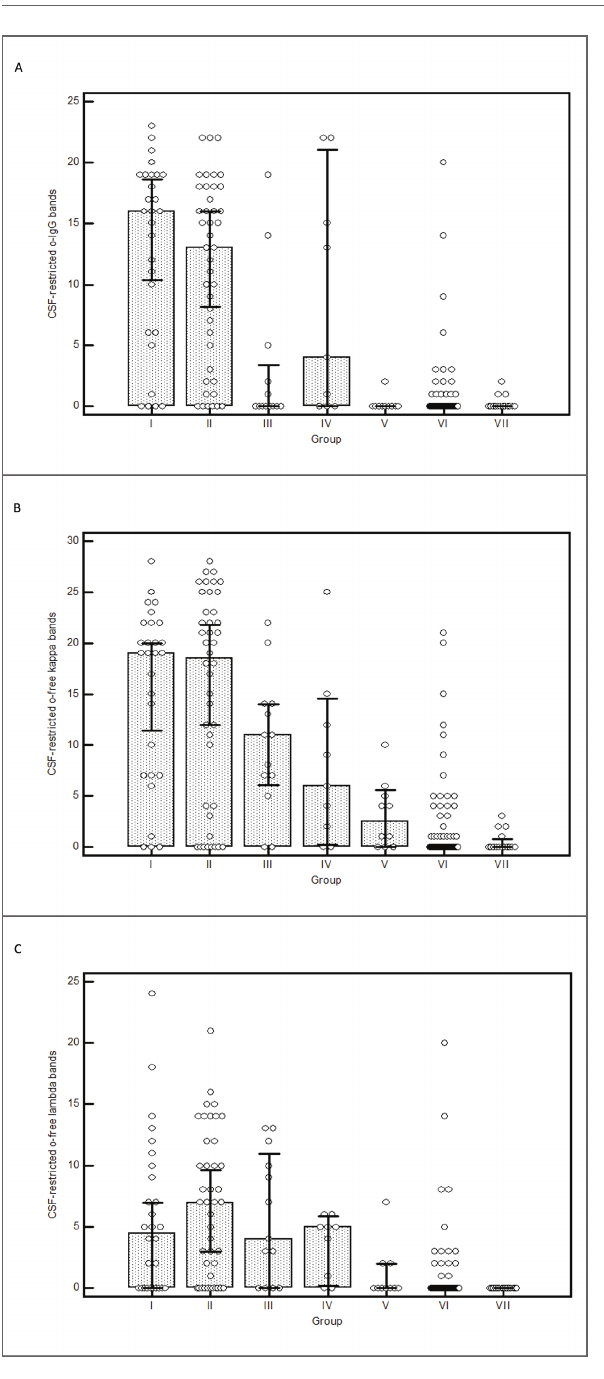
Fig. 2. Numbers of CSF-restricted oligoclonal bands in the individual disease groups. Bars for medians; error bars: 95% confidence intervals for medians I = multiple sclerosis, II = clinically isolated syndrome, III = CNS infectious diseases, IV = other inflammatory CNS diseases, V = immune-mediated neuropathies, VI = non-inflammatory neurologic diseases, VII = control group. (A) oligoclonal IgG, (B) oligoclonal free κ, (C) oligoclonal free λ.